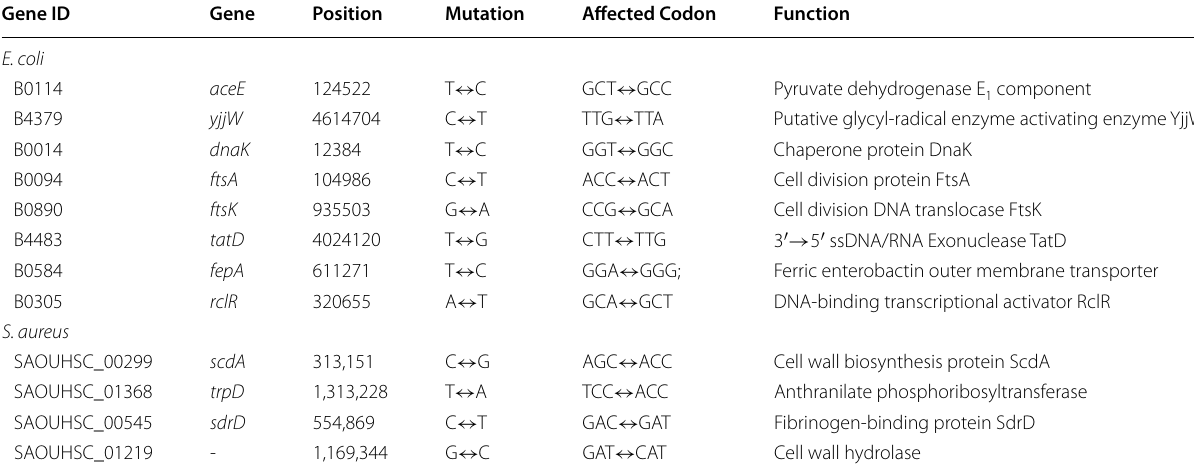
Table 1 Significantly important functional genes in